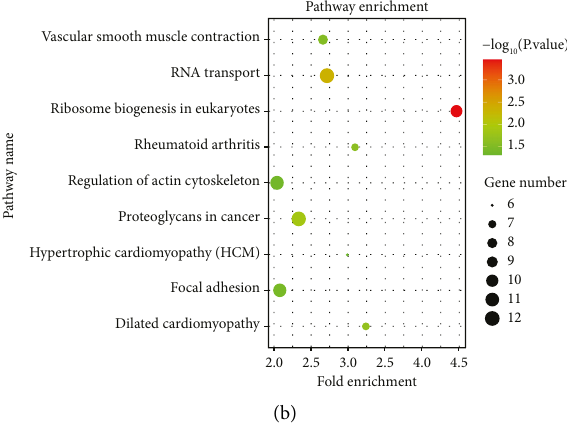
Figure 3: Barplots of GO enrichment analysis (top 20) and Dotplot of KEGG pathway enrichment analysis. (a) Y -axes show GO enrichment significance items of DEGs in three different functional groups (molecular function, biological processes, and cell composition), and x -axes represent the gene counts enriched in each GO term. Different bar colors represent different adjust P values. Abbreviations: DEGs, differentially expressed genes; GO, gene ontology. (b) Dotplot of KEGG pathway enrichment analysis. Each dot represents a KEGG pathway, and the size of each dot indicates the number of genes in the enrichment